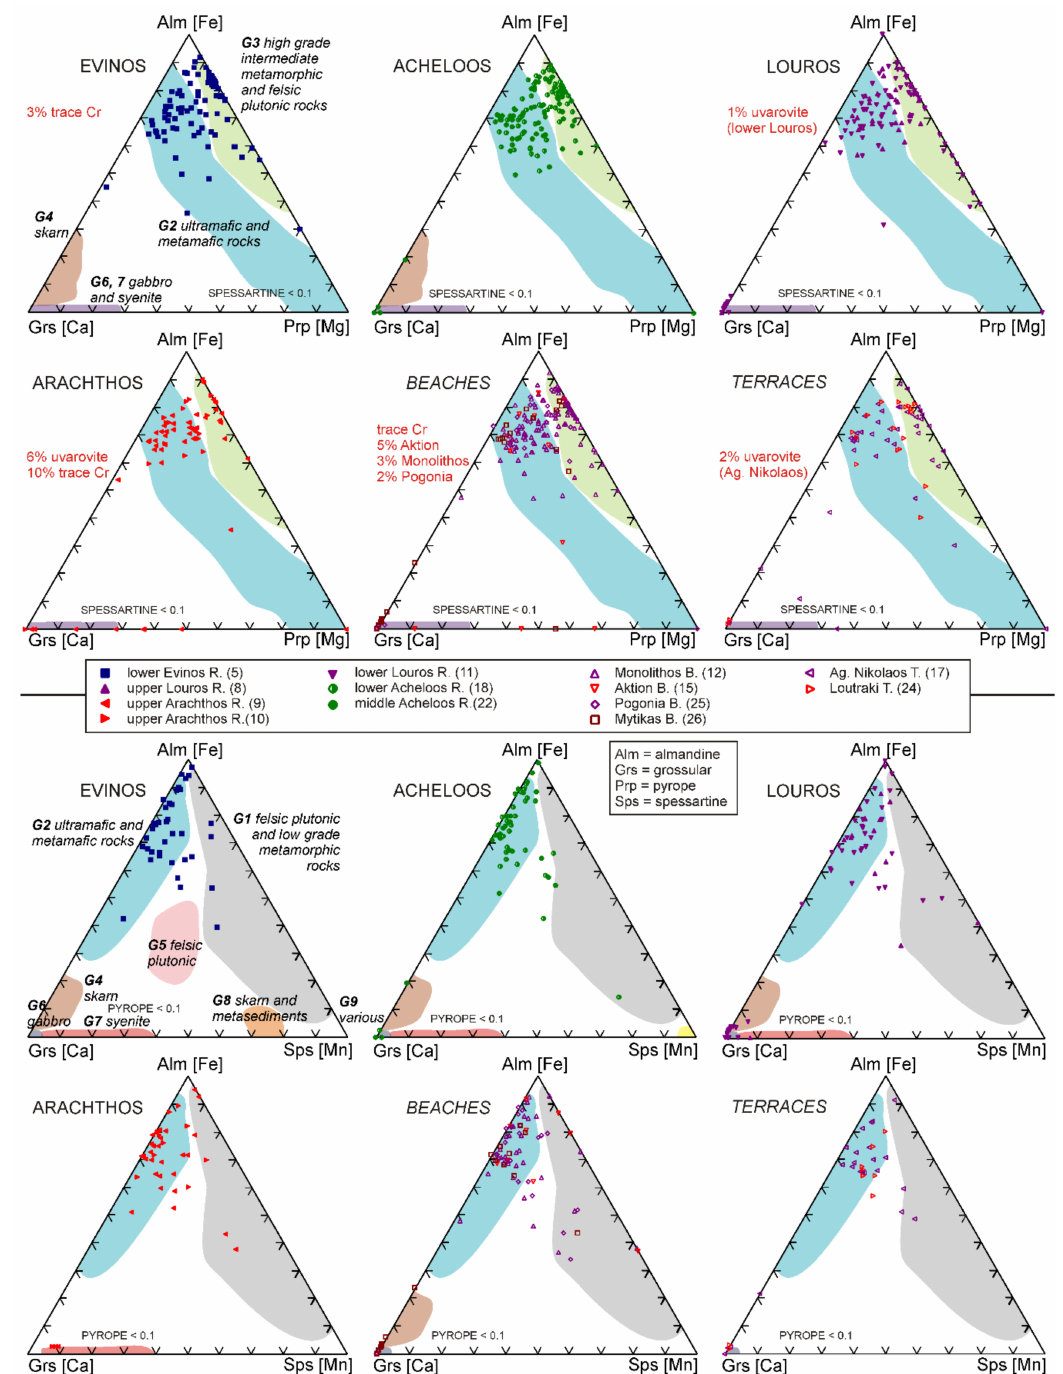
Figure 6. Standard classification diagram for garnet. Fields G1–G9 from [45] based on analyses from [46] shown only for Evinos River sample. Upper panels for analyses with <10% spessartine, lower panels for analyses with <10% pyrope end